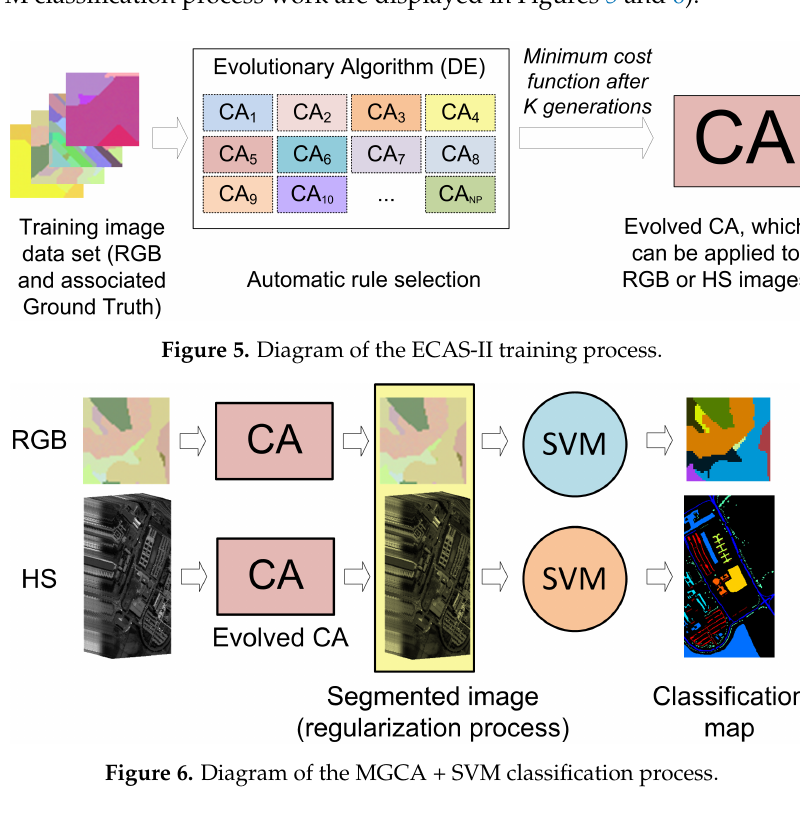
Figure 6. Diagram of the MGCA + SVM classification